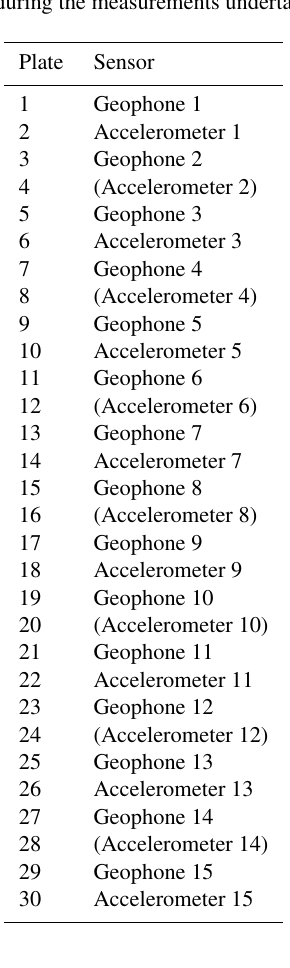
Table 1. Numbering of the steel plates (left column) and the sen- sors (right column), indicting their lateral distribution; plate 1 is at river right hand side, plate 30 at river left hand side (see Fig.